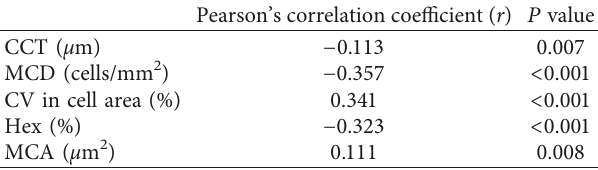
Table 3: Correlation between age and variables pertaining to the corneal endothelial cell density and morphology in Egyptian subjects with healthy eyes.